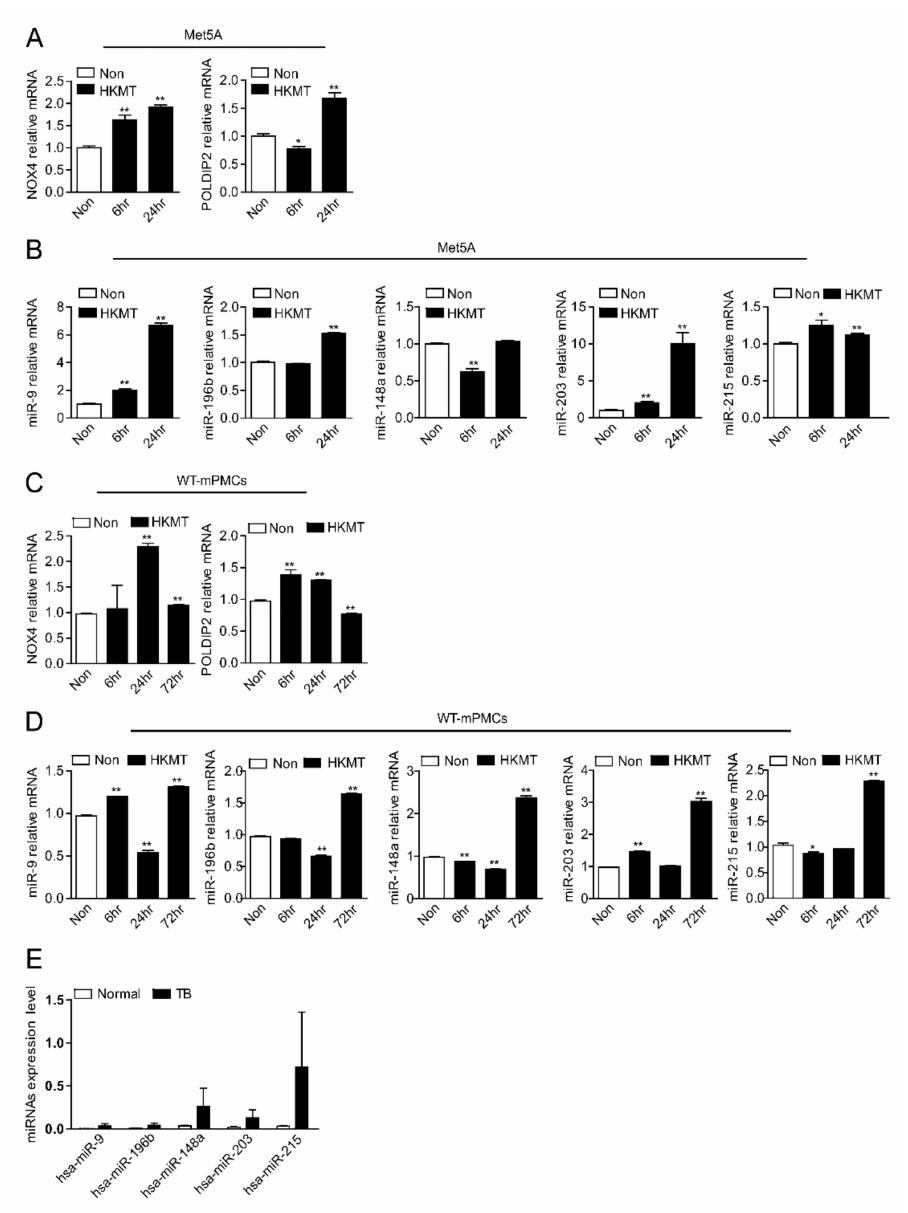
Figure 3. miR-148a decreased in the early stage of HKMT stimulation but increased as the exposure time increased. ( A ) NOX4, POLDIP2 mRNA expression in the Met5A cells pre-incubated with HKMT (10 ng/mL) for indicated times ( n = 3). ( B ) qRT-PCR analysis of miRNA expression in Met5A cells pre-incubated with HKMT (10 ng/mL) for indicated times ( n = 3). Results are presented as the mean ± SEM ( C ) NOX4, POLDIP2 mRNA expression in the WT-mPMCs pre-incubated with HKMT (10 ng/mL) for indicated times ( n = 3). ( D ) qRT-PCR analysis of miRNA expression in